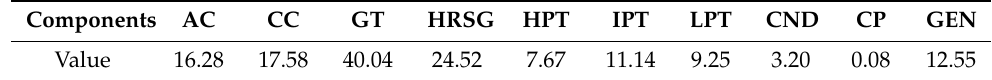
Table 3. Investment cost of each piece of equipment (million